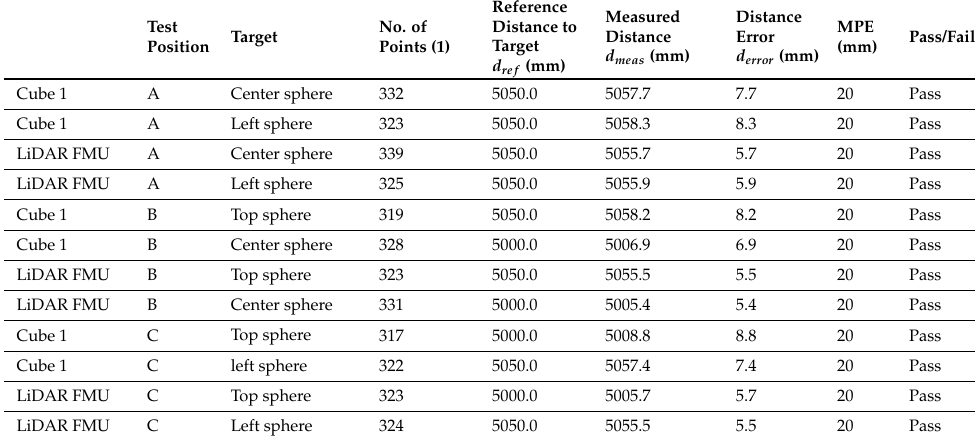
Table 5. Results of asymmetric